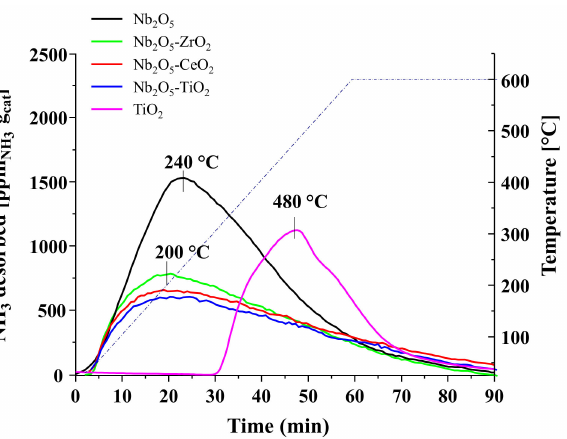
Figure 5. NH 3 -TPD curves of the samples registered versus time by heating from room temperature